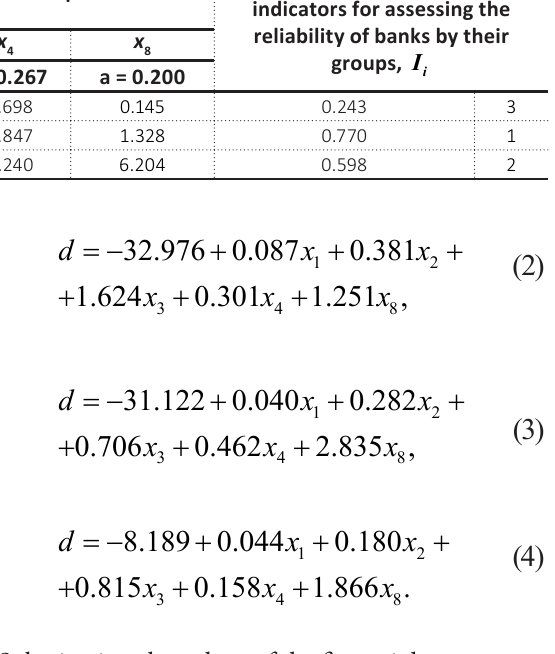
Table 7. The results of the integrated assessment of the Ukrainian banks reliability within the existing clusters Average values and weights ( a ) of banks’ financial parameters Value and rating of taxonomic i Cluster